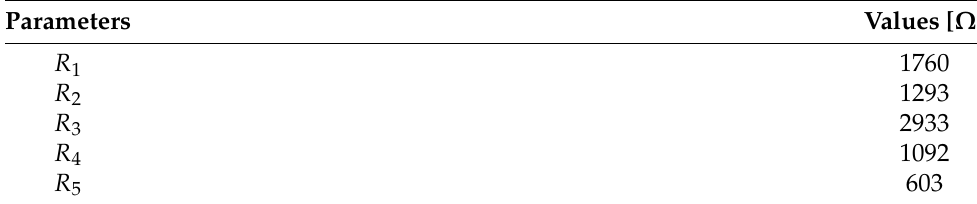
Table 2. Values of the resistances of the electrical circuit.